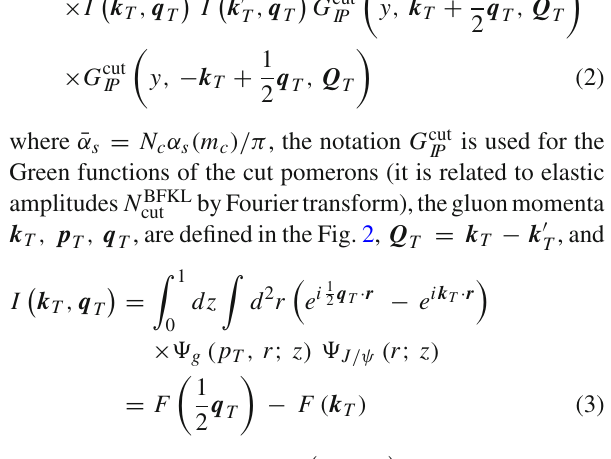
Fig. 2 The cross-section corresponding to the first diagram of the Fig. 1 in the BFKL Pomeron calculus..The vertical wavy lines of different colors and shape passing through unitarity cut are BFKL Pomerons [described by the Green functions G IP ( y , k T ) in Eq. (2)], helical lines correspond to the gluons